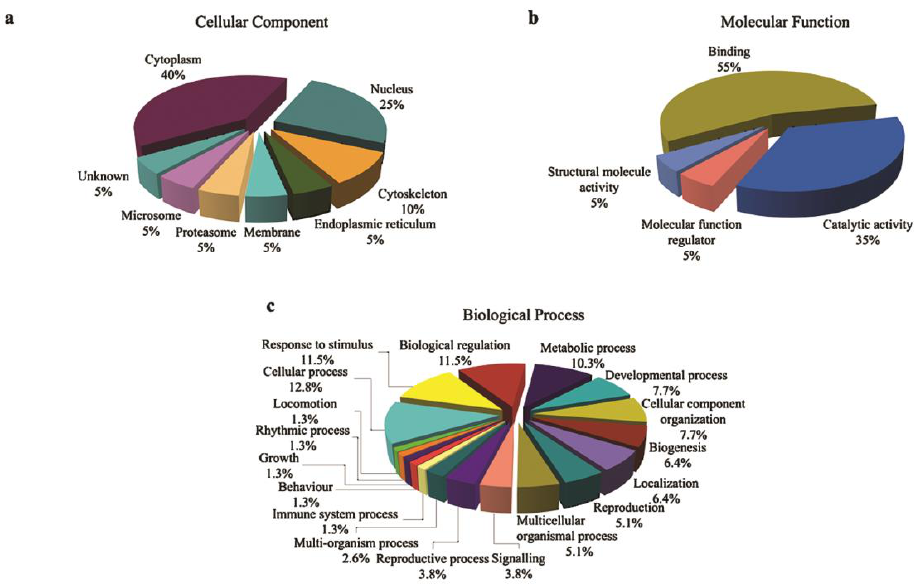
Figure 3. Gene ontology (GO) categories of identified proteins expressed by Coptotermes curvignathus infected by Metarhizium anisopliae during pathogenesis development. Identified proteins were annotated and grouped to their respective protein categories: ( a ) cellular component, ( b ) molecular function, and ( c ) biological process using the GO Slim software.